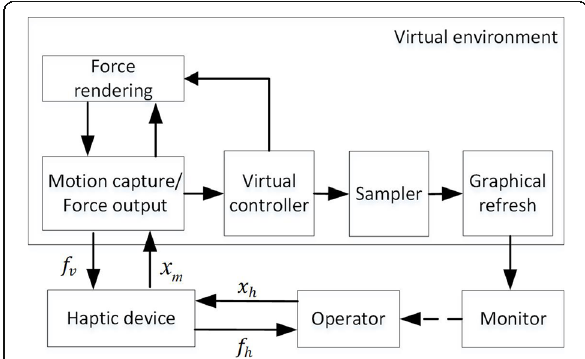
Fig. 4 Schematic diagram of the VR-based haptic interaction